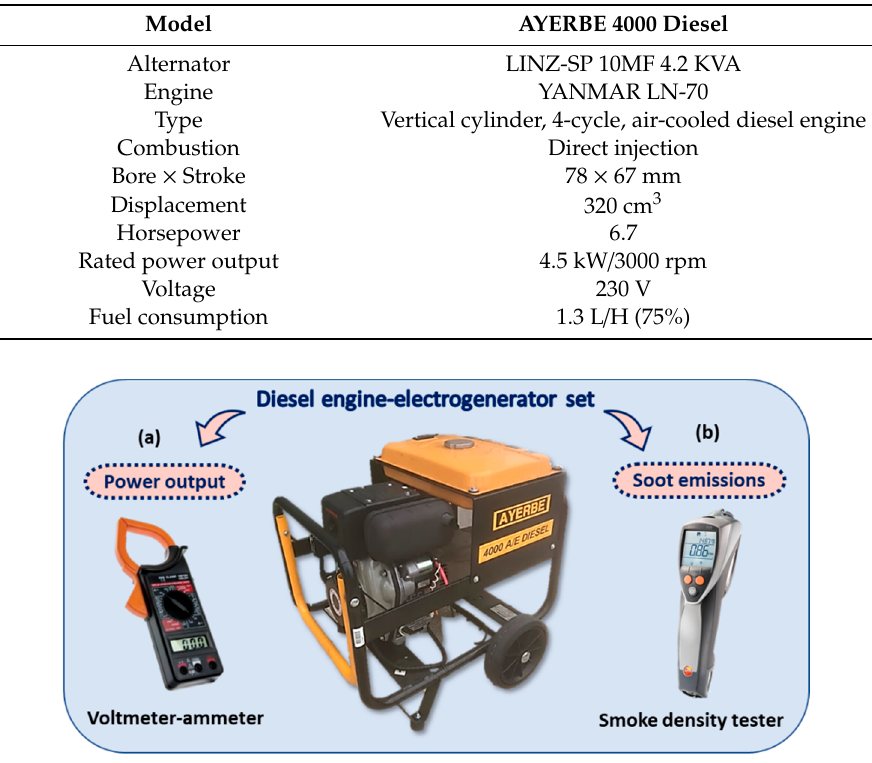
Figure 1. Scheme of methodology on a Diesel Engine-Electrogenerator Set to determine ( a ) power output by using a voltmeter–ammeter devise; ( b ) generated soot emissions by using smoke density tester. Table 2. Technical specifications of the Diesel Engine-Electrogenerator Set.